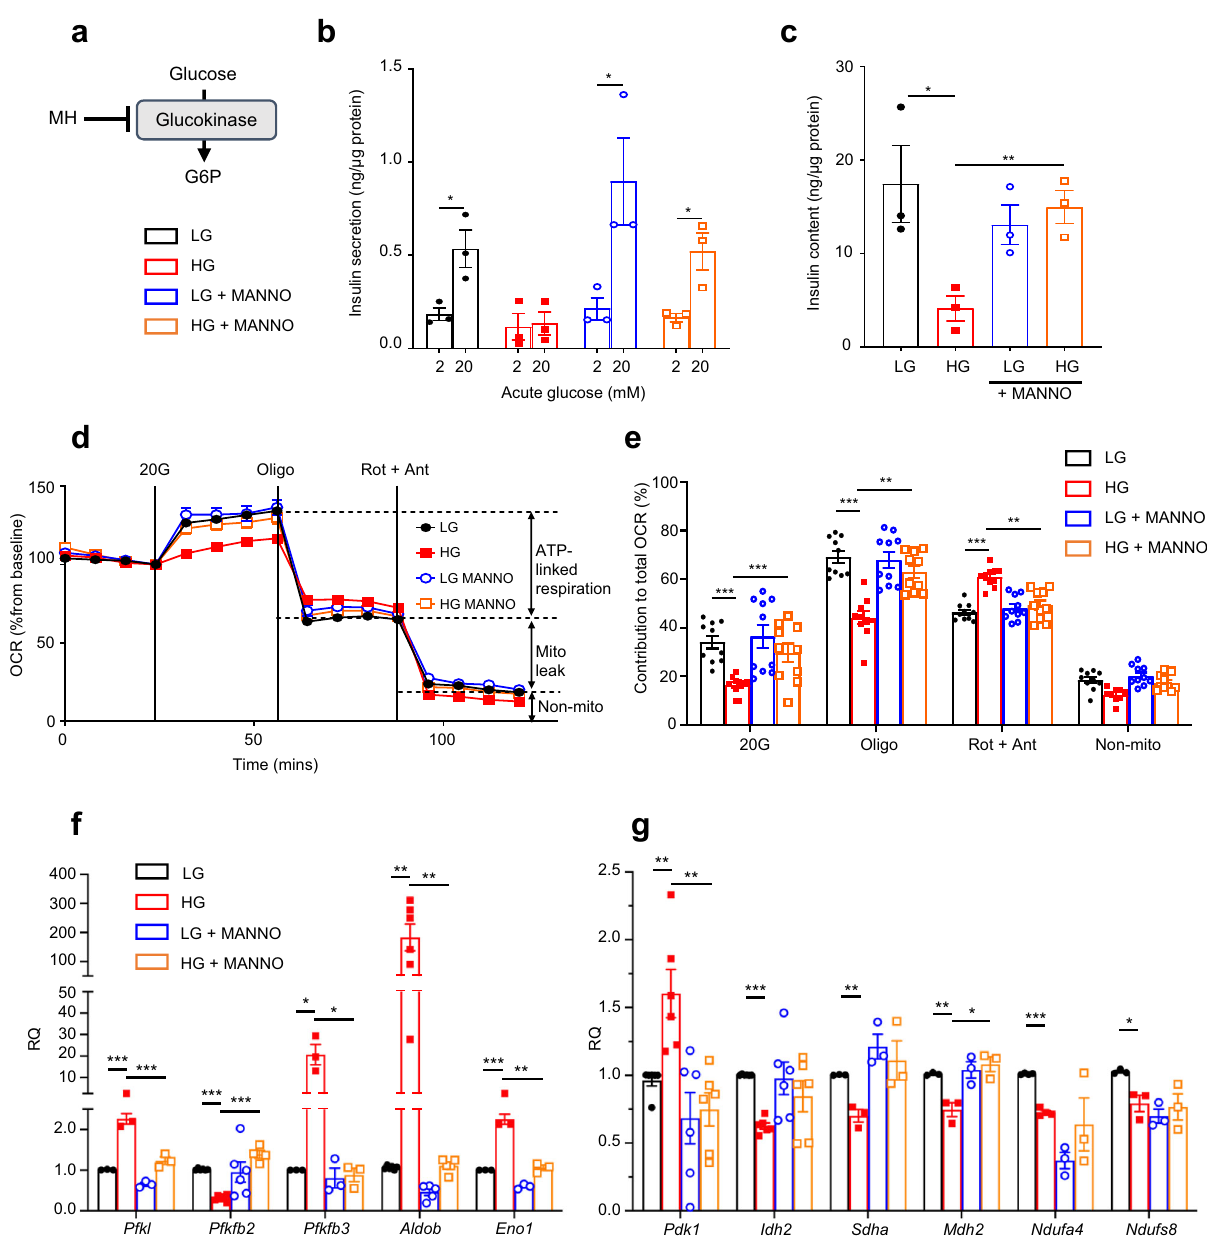
Fig. 1 | Inhibition of glucokinase prevents the effects of chronic hyperglycae- mia. a Schematic showing how mannoheptulose (MH) inhibits glucose metabo- lism. b , c Insulin secretion ( b ) and insulin content ( c ) in LG-cells and HG-cells cultured for 48h±10mM mannoheptulose (MANNO) and then stimulated with 2mM or 20mM glucose. Mannoheptulose was omitted during the assay ( n =3 biologically independent experiments). d Oxygen-consumption rate (OCR) in LG- cells and HG-cells cultured for 48h±10mM MANNO. OCR was recorded at 2mM glucose and after sequential addition of 20mM glucose (20G), 1 μ M oligomycin (Oligo) and 0.5 μ M rotenone+0.5 μ M antimycin A (Rot+Ant). Data are expressed as the percentage change from baseline (2mM glucose); n =10 biologically inde- pendent experiments per group. e Percentage change in OCR when glucose was raisedfrom 2 to 20mM (20G),ATP-linked OCR (Oligo),OCRrequired to maintain the mitochondrial leak (Rot+Ant) and non-mitochondrial OCR (non-mito); n =10